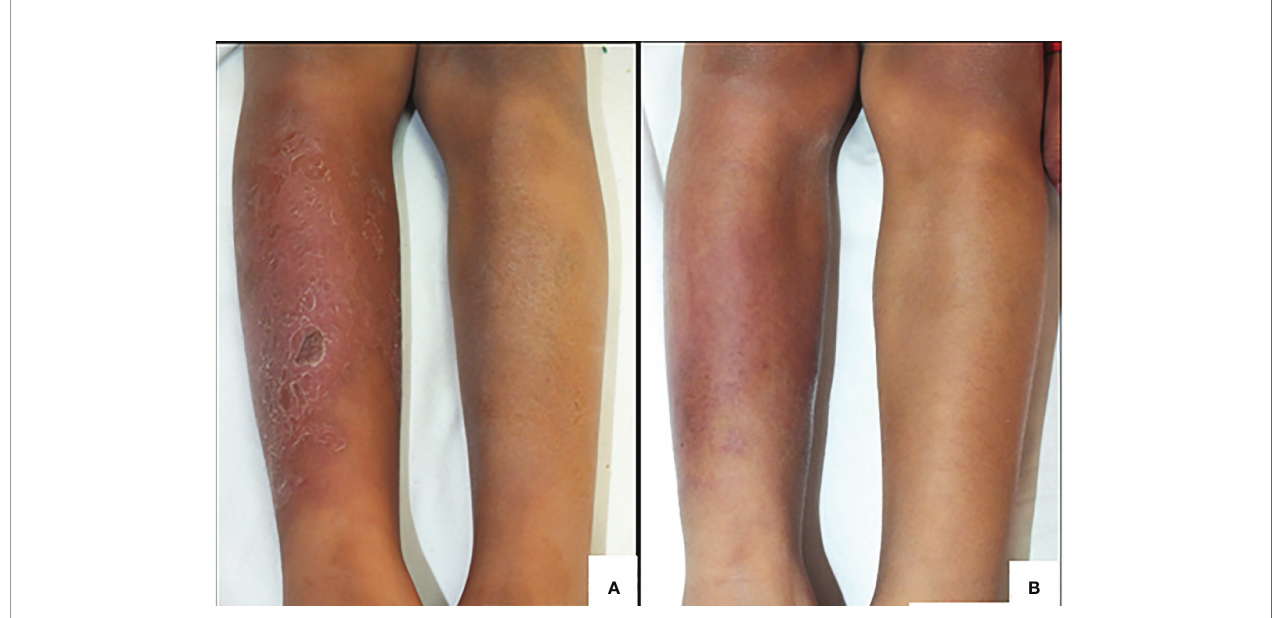
FIGURE 3 | (A) Erythematous plaque and brownish crusts in the right leg of Case 2. (B) Improvement of lesion after